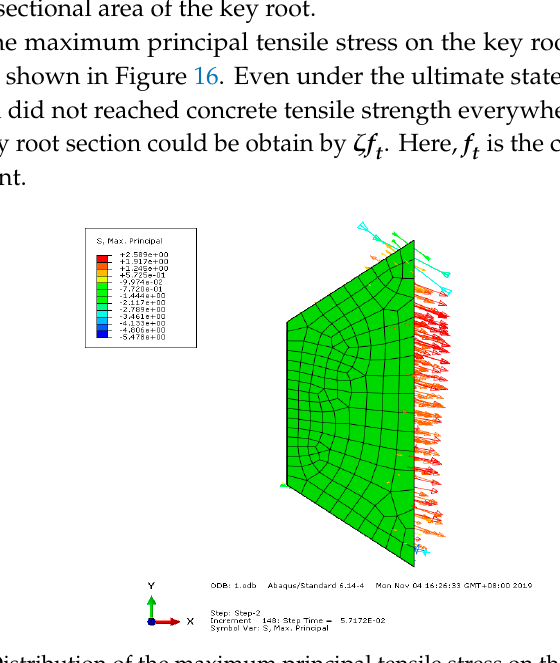
Figure 16. Distribution of the maximum principal tensile stress on the key root section.